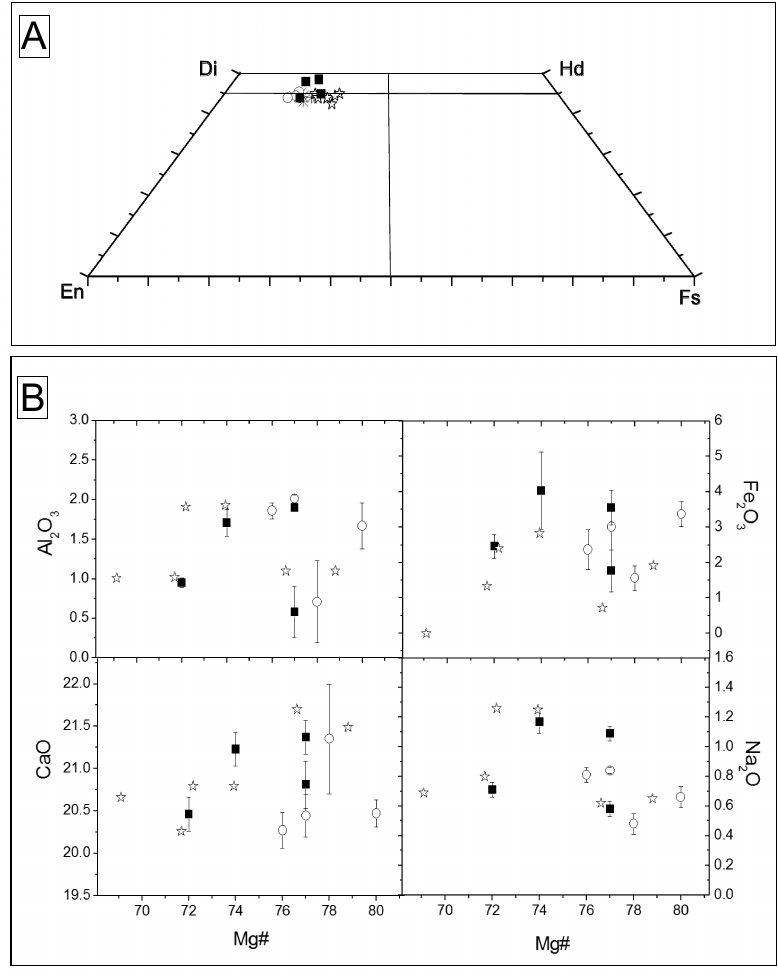
Figure 5. ( A ) Pyroxene classification diagram. Symbols: full square: host-clinopyroxene; empty circle: enclaves-clinopyroxene; asterisk: clinopyroxene from [38]; and star: clinopyroxene from [37]. ( B ) Selected oxides composition against Mg#. Symbols as